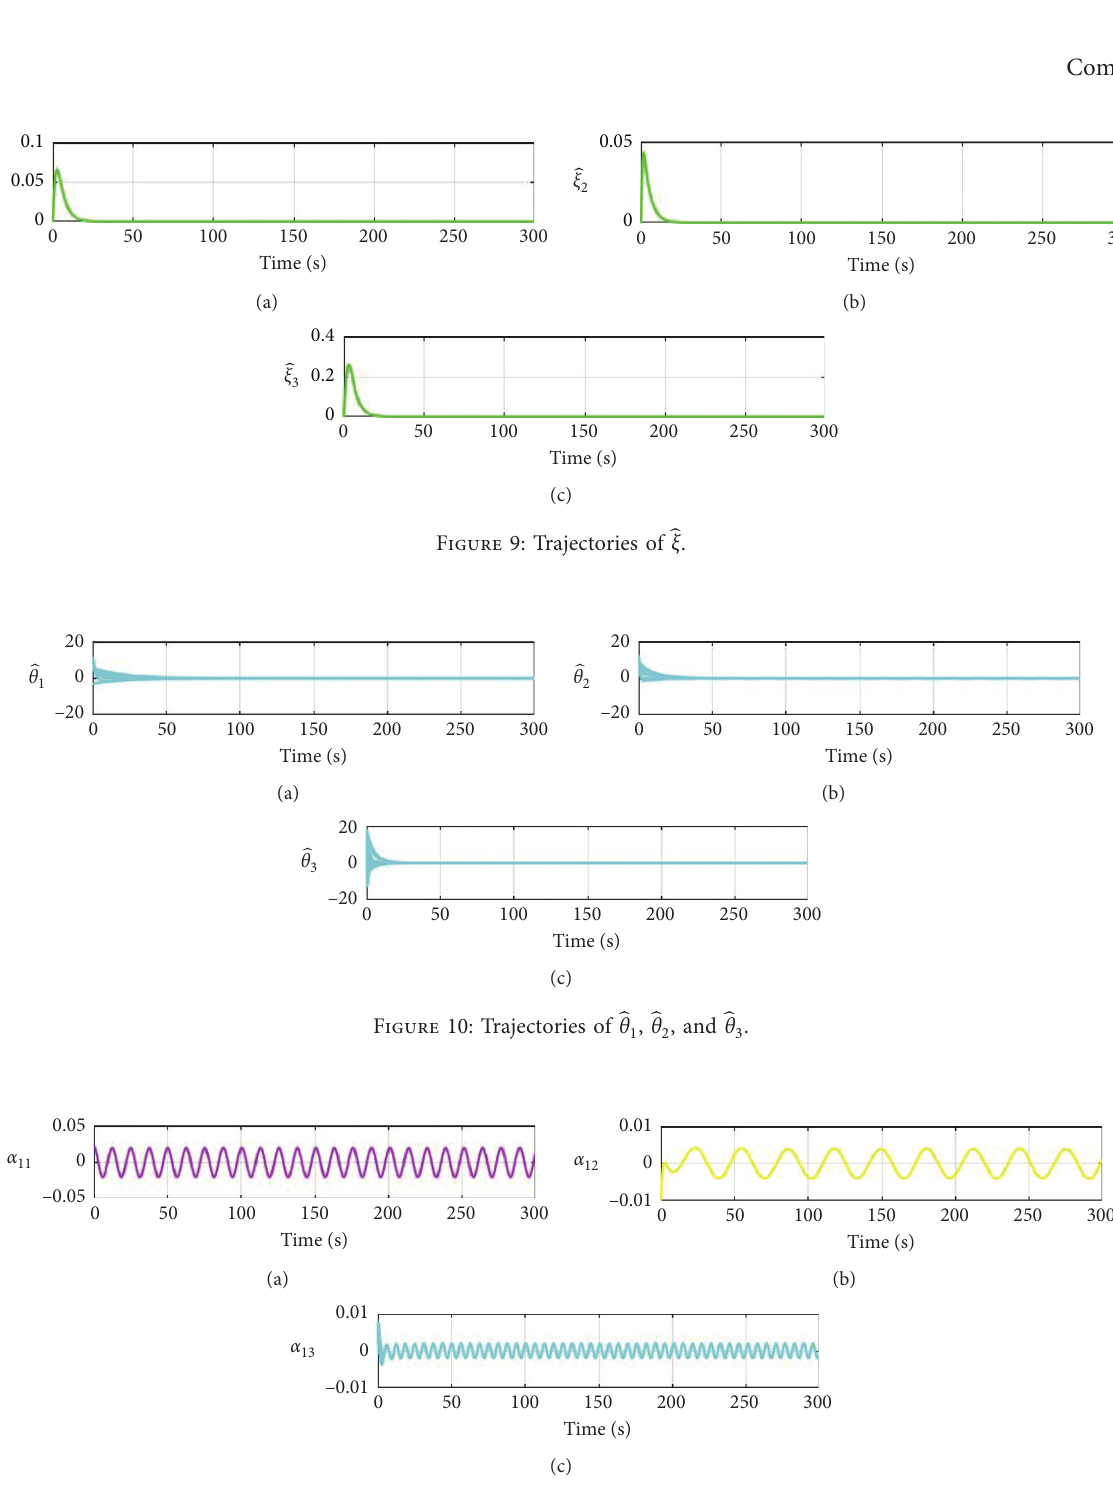
Figure 11: Trajectories of virtual controller α